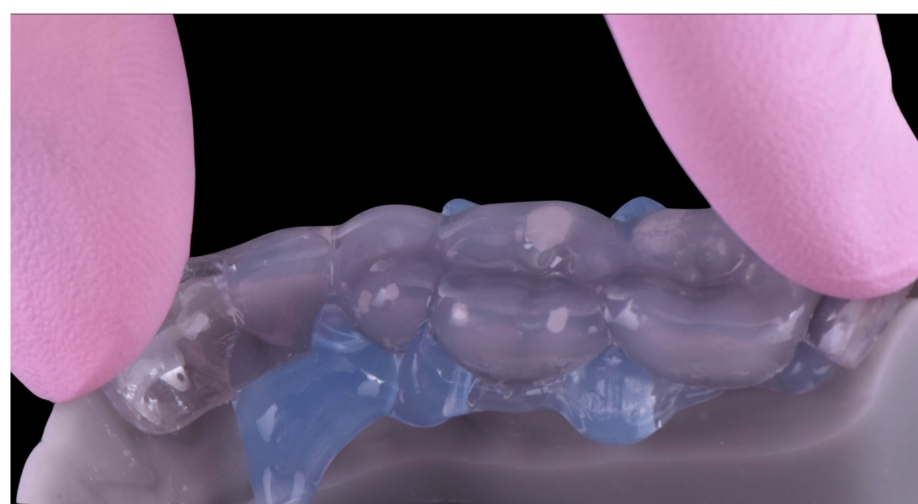
Figure 15. Transparent silicone (Memosil).